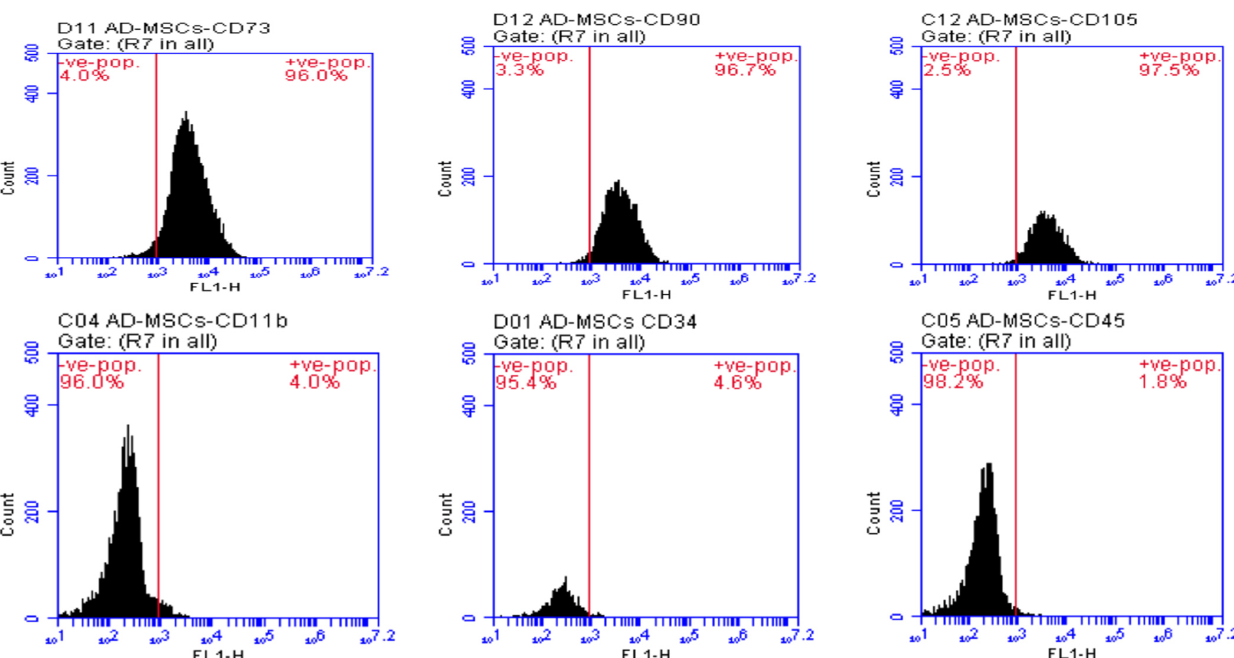
Figure 2. AD ‐ MSCs positive surface markers (CD 73: 96.0%, CD 90: 96.7%, CD 105: 97.5%); AD ‐ MSCs negative surface markers (CD 11b: 4.0%, CD 34: 4.6%, CD 45: 1.8%).